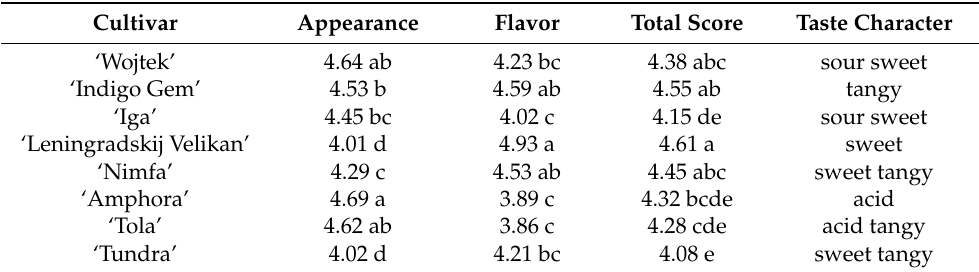
Table 4. Sensory characteristics of honeysuckle cultivars, 2018–2020. Cultivar Appearance Flavor Total Score Taste Character ‘Wojtek’ ‘Indigo Gem’ ‘Leningradskij Velikan’ ‘Amphora’ ‘Tundra’ Different letters represent statistically significant differences ( p < 0.05) between values within the same